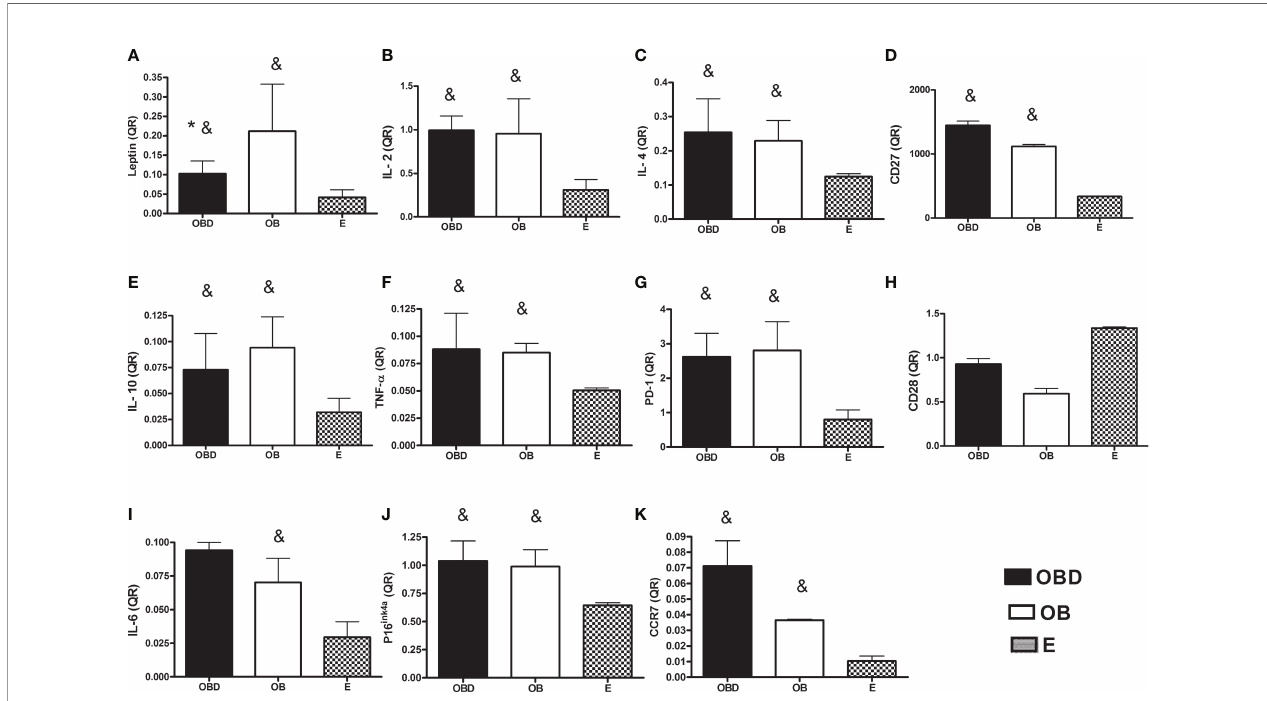
FIGURE 1 | Gene expression of leptin (A) , IL-2 (B) , IL-4 (C) , CD27 (D) , IL-10 (E) , TNF- a (F) , PD-1 (G) , CD28 (H) , IL-6 (I) , P16 ink4a (J) and CCR7 (K) in PBMCs of obese diabetic (OBD) or Obese without associated disease (OB) or Eutrophic (E) middle-aged individuals.* Signi fi cantly different from OB; & Signi fi cantly different from E; p ≤ 0.05.